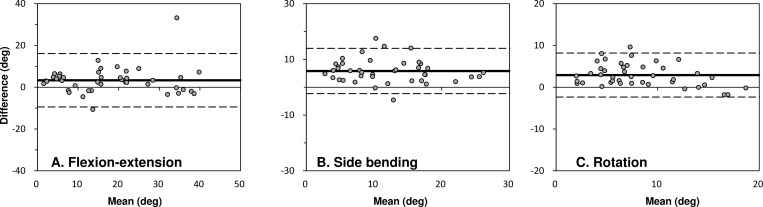
Bland–Altman plots of the evaluation results.The x-axis shows the average value of the angle obtained by stretch sensor and by the optical motion capture system. The y-axis shows the difference between the angles. The dashed lines denote ±1.96 SD (standard deviation), that 95% of the differences are in between the lines.